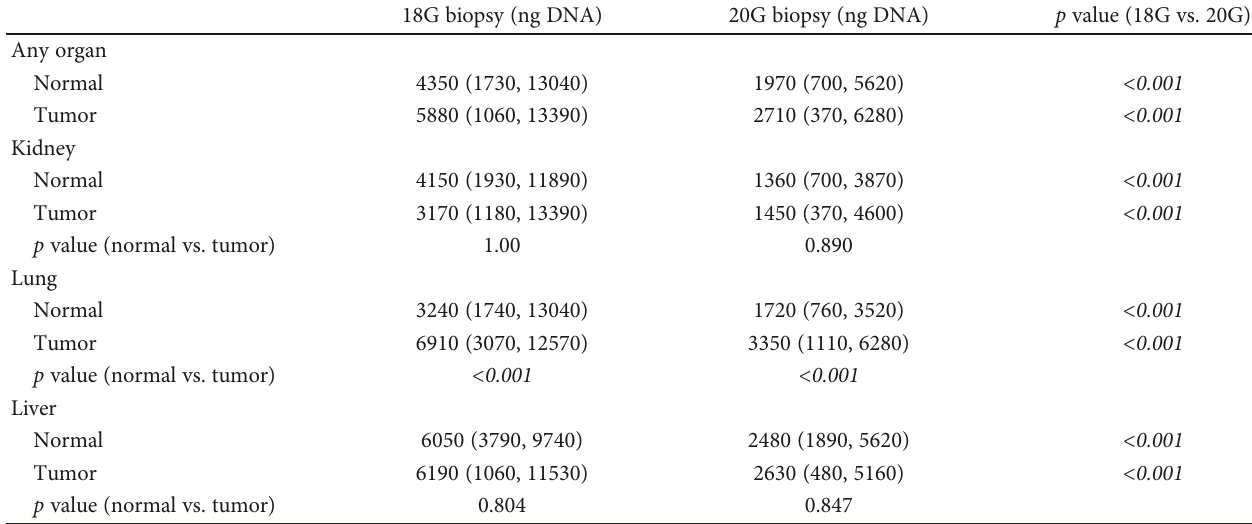
Table 2: Median DNA (range) from 18- versus 20-gauge needle samples from normal and tumor tissues obtained from the kidney, lung, and liver.